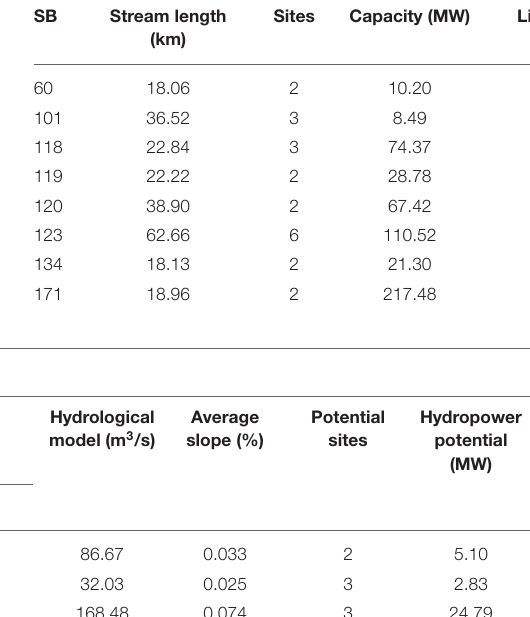
TABLE 5 | Linear density of hydroelectric generation by the sub-basin.